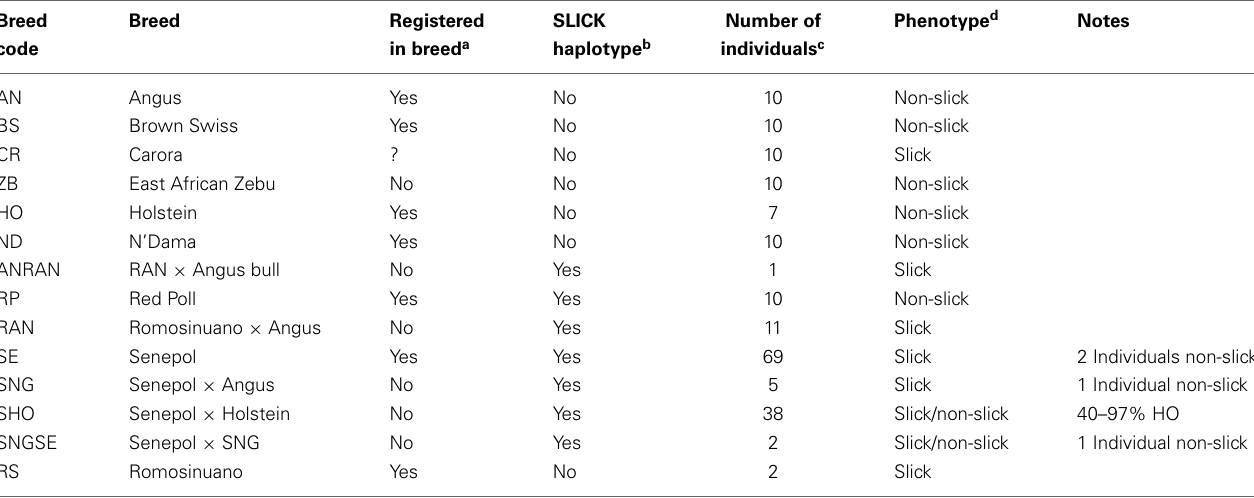
Table 1 | One hundred and ninety-five cattle were utilized in the genetic analyses of the slick hair phenotype. Breed